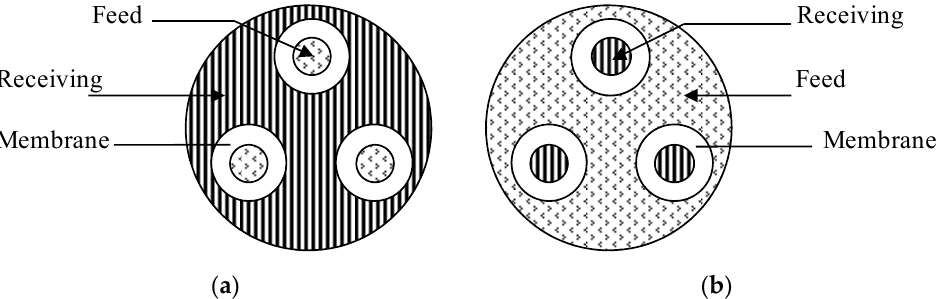
Figure 2. Tailor-made liquid membrane annular contactor operating modes: ( a ) mode A for separation purposes: feed inside small fibers and receiving outside of large fibers; ( b ) mode B for preconcentration purposes: receiving inside small fibers and feed outside of large fibers.